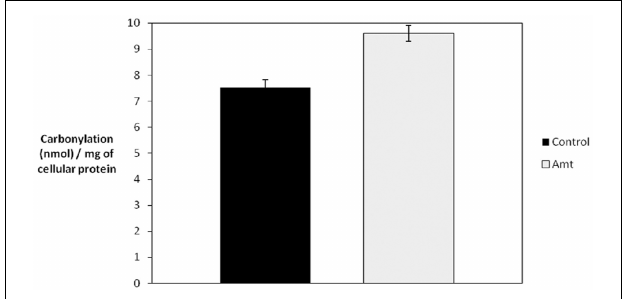
FIGURE 4 | Catalase inhibition results in increased protein carbonylation. Hs27 fibroblasts were grown in the presence or absence of 2mM 3-AT for 4days and protein carbonylation was determined. A quantitative spectrophotometric assay involving the derivatization of carbonyl groups with 2,4-dinitrophenylhydrazine was used, as described in Section “Materials and Methods.” An ∼ 7% increase in total cellular carbonyls was observed in cells treated with 3-AT ( p < 0.05).